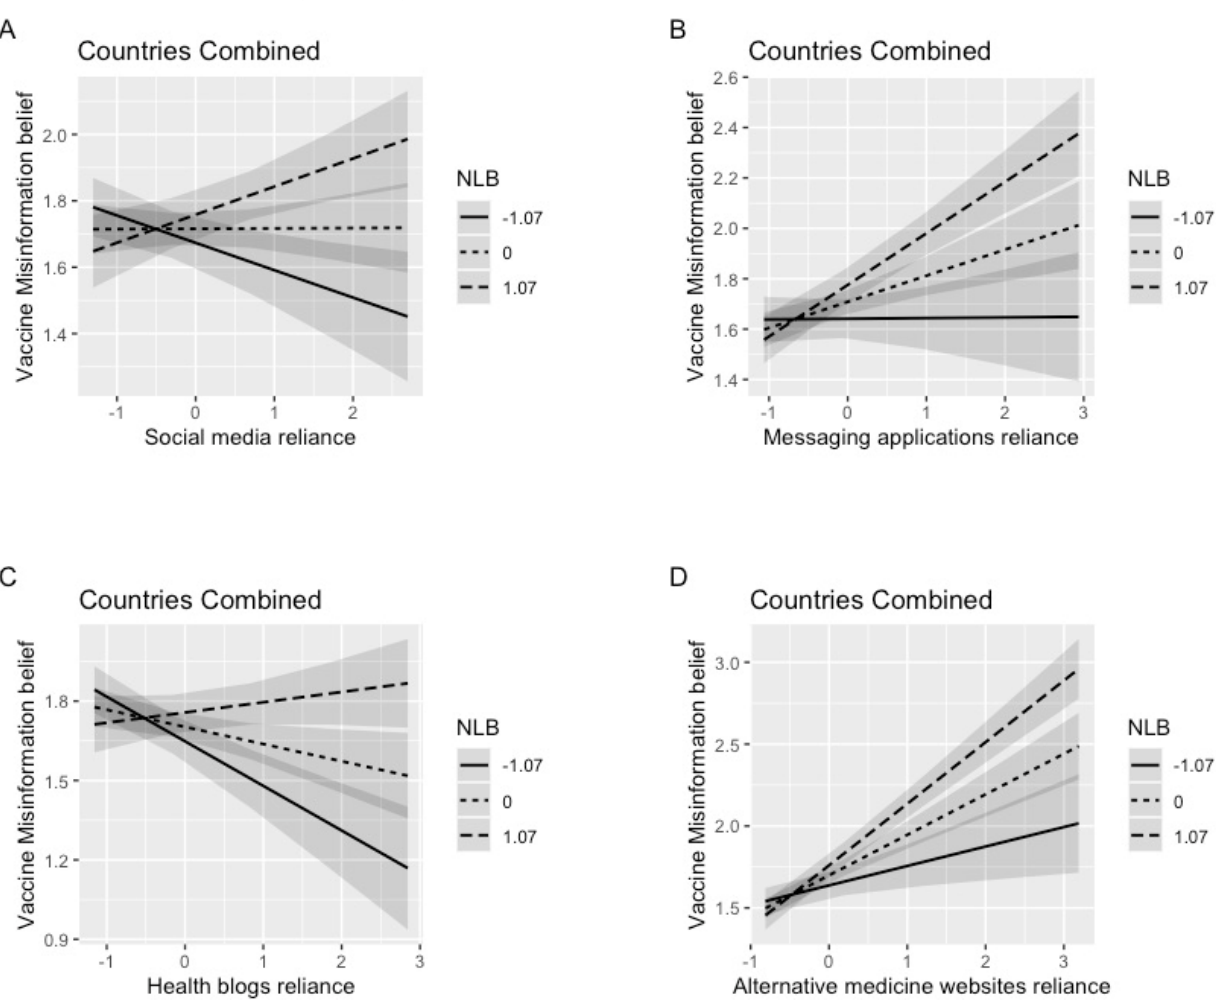
Figure 2. Two-way interaction between media reliance and NLB on vaccine-related misinformation belief (Combined sample). Note. Plots represent marginal effects at − 1 SD, Mean, and +1 SD. Figure A – D represents the interaction between NLB and reliance on (1) social media, (2) messaging applications, (3) health blogs and (4) alternative medicine website